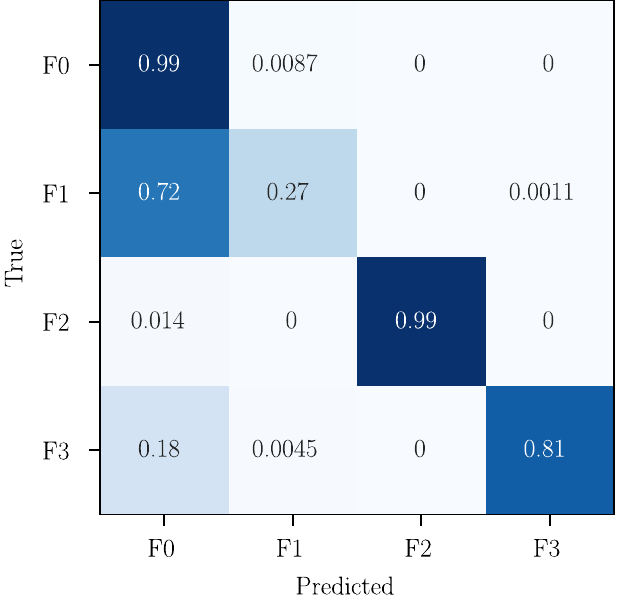
Figure 9. Confusion matrix for the target dataset FDD obtained with a model trained using only a few target samples (Target →